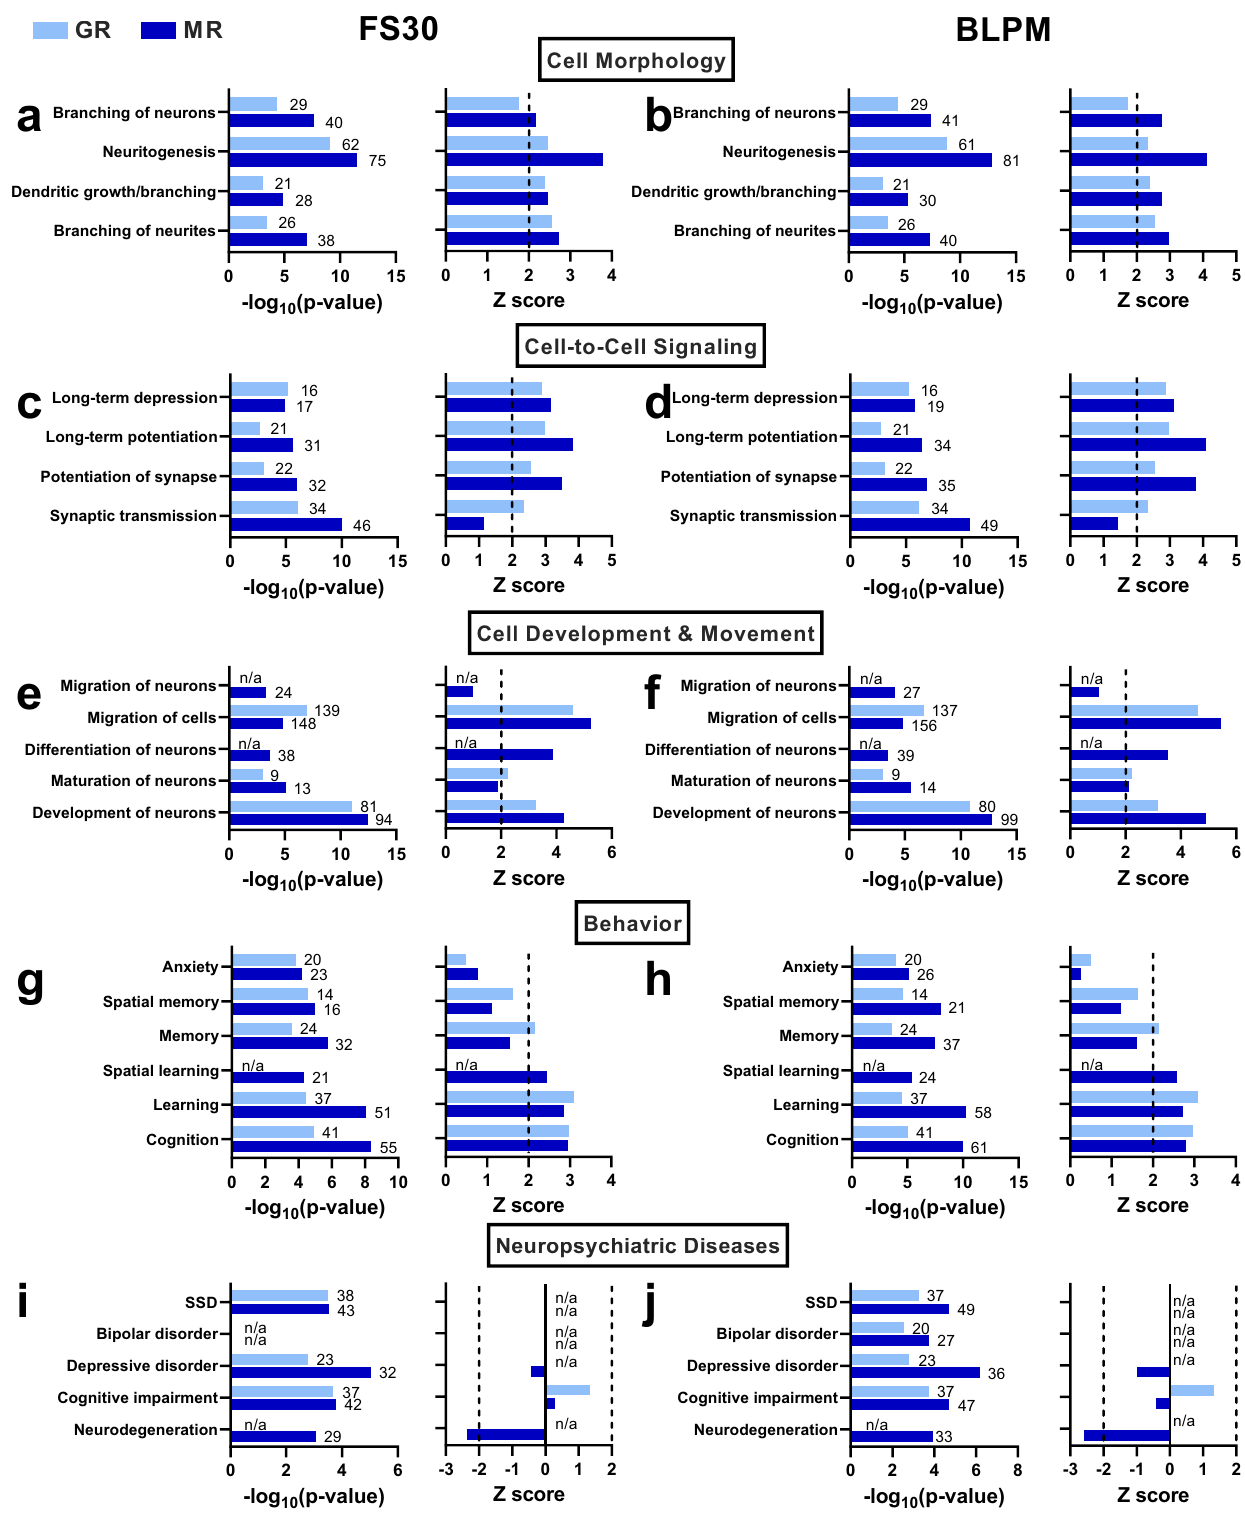
Fig. 7 Ingenuity Pathway Analysis (IPA) analysis of MR and GR ChIP-Seq data. IPA analysis was conducted on MR and GR ChIP-Seq FS30 ( a , c , e , g , i ) and BLPM ( b , d , f , h , j ) data sets at FDR ≤ 0.1. The graphs represent pathways signi fi cantly associated with differentially bound MR- and GR-binding genes (dark blue and light blue bars, respectively) for top terms relating to Cell Morphology ( a, b ), Cell to Cell Signalling ( c, d ), Cell Development and Movement ( e, f ), Behavior ( g, h ), and Neuropsychiatric Diseases ( i, j ). The number of genes within the dataset relating to each term is provided next to the corresponding bar. The Z-score was determined to infer the activation state of the gene within the molecular network. Z-scores of > + 2 indicate that the gene is considered signi fi cantly activating within the network, whereas scores of <-2 are regarded as signi fi cantly inhibiting. Source data are provided in